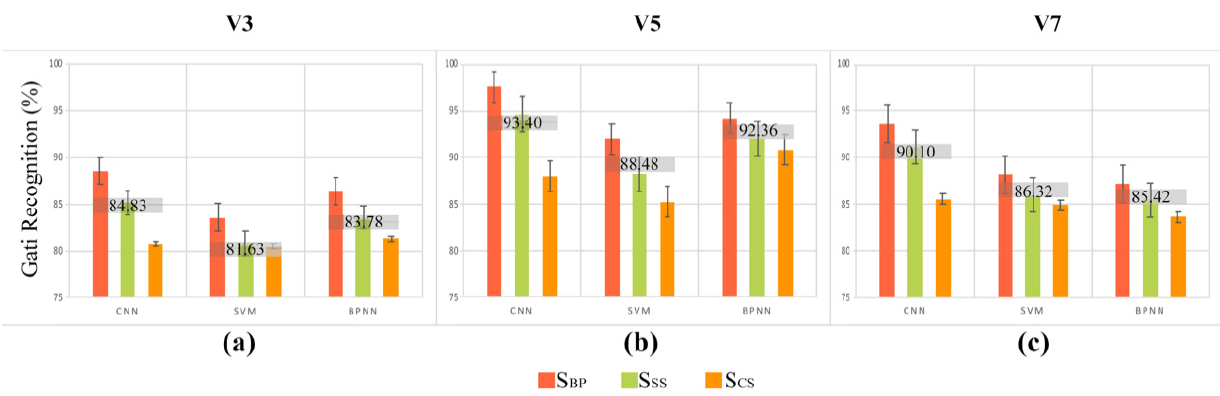
Figure 3. Gait recognition comparisons among three load styles with three algorithms at three speeds (V3 ( a ), V5 ( b ) and V7 ( c )).